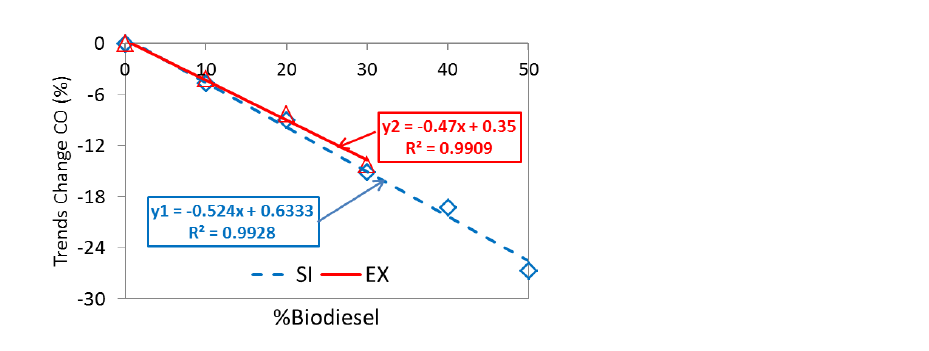
Figure 12. Relationship between CO emissions and biodiesel blending ratio of simulation (SI) and experiment (EX).